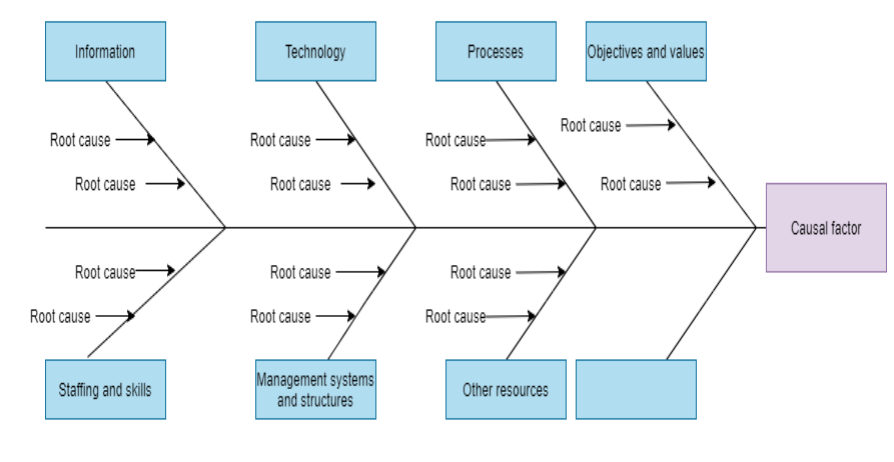
Figure 1: Fishbone diagram with seven root cause categories (ITPOSMO dimensions)